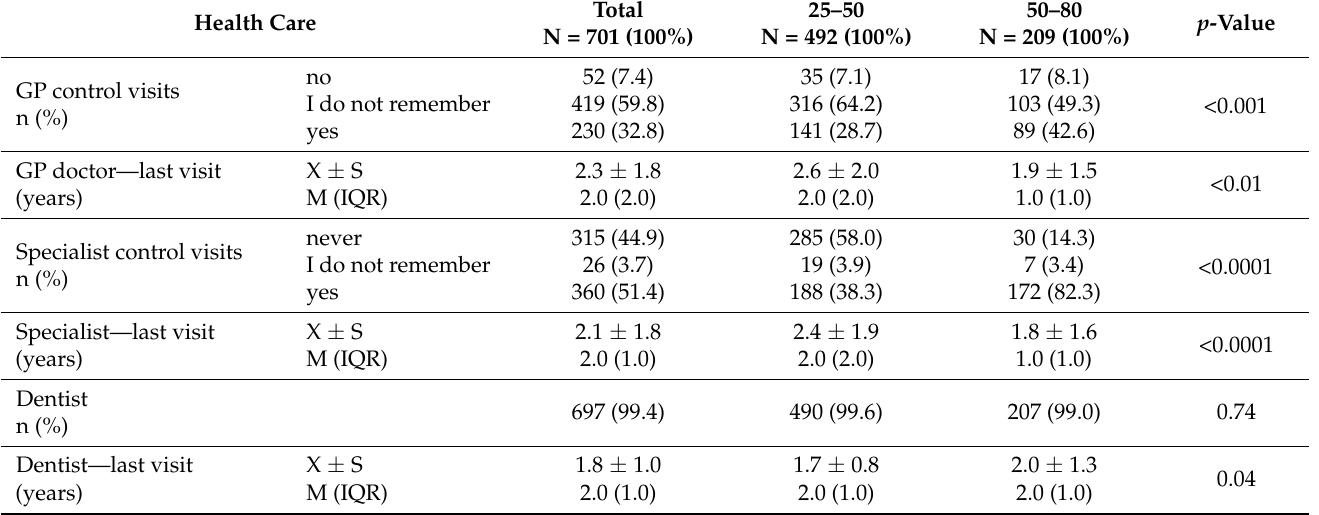
Figure 1. The most common diseases in the group of surveyed doctors (N = 701; 100%). Moreover, 464 (66.2%) of the surveyed doctors declared constant use of drugs, includ- ing antiplatelet drugs ( n = 192; 27.4%), anticoagulants ( n = 49; 7%), hypoglycemic drugs ( n = 101; 14.4%), antihypertensive ( n = 238; 34%), lipid-lowering ( n = 101; 14.4%), sedatives ( n = 81; 11.6%), and others ( n = 255; 36.4%). Pharmacotherapy was significantly more common in the older age group in comparison to the younger ( n = 189; 91.3% vs. n = 275; 56.1%; p < 0.0001) and mainly applied to people with chronic diseases ( n = 459; 98.9%). Two hundred and thirty (32.8%) of the respondents used the advice of a primary care physician, while 360 (51.4%) consulted specialist doctors (Table 1). It is worth adding that senior doctors underwent health condition monitoring significantly more frequently, with the exception of dental visits. In this age group (50–80), preventive actions were significantly more frequent, but those people also required sick leave at a significantly higher rate. Table 1. Data on health control in the group of examined doctors.